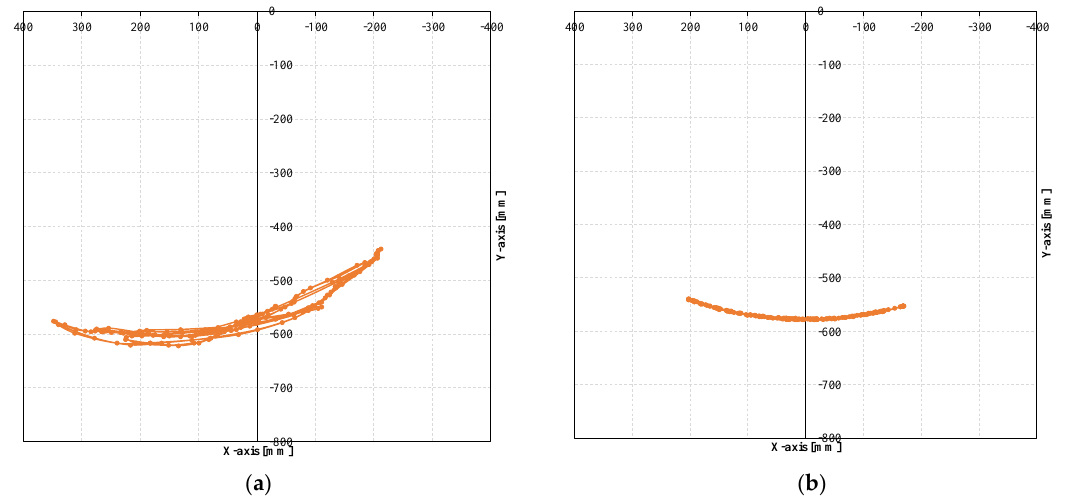
Figure 10. Trajectory of the leg tip using evaluation function 2 without load (( a ) first generation, ( b ) 18th generation).